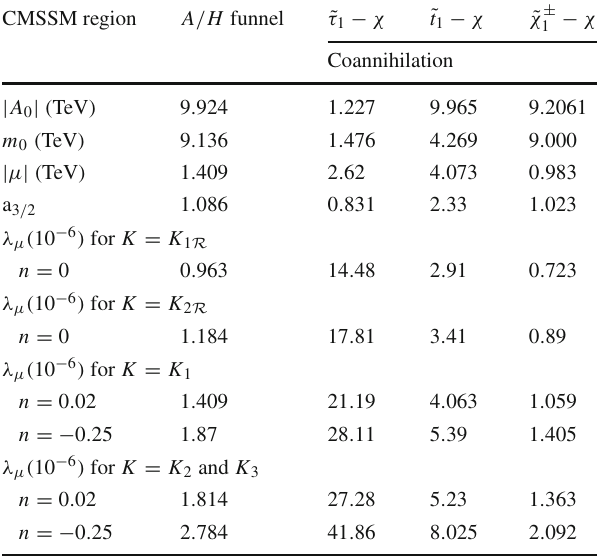
Table 5 The required λ μ values rendering our models compatible with thebest-fitpointsoftheCMSSMasfoundinRef.[104]withtheassump- tions in Eq.